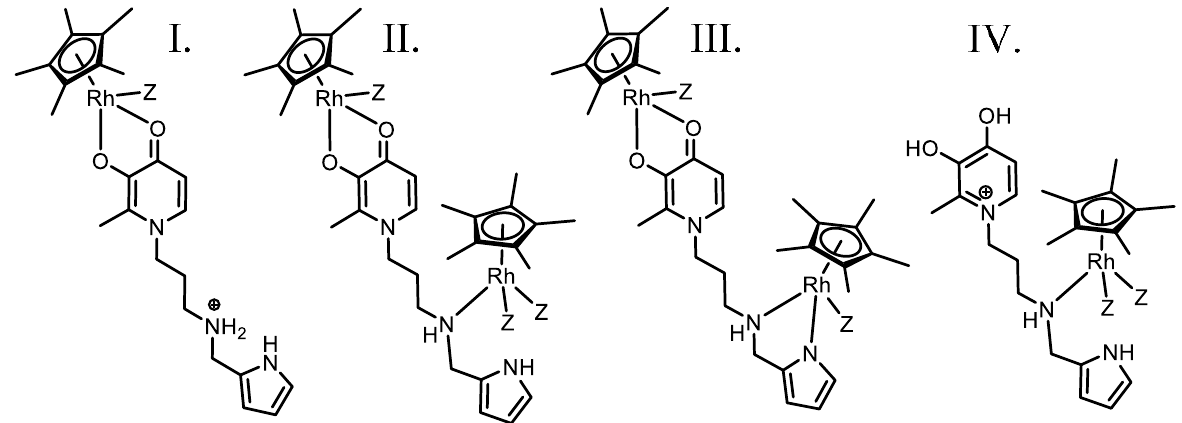
Figure 8. Suggested structures of the species in the [( η 5 -Cp*)Rh] 2+ –L3 system (Z = Cl − /H 2 O), charges of the metal ions are omitted for clarity. ( I ) [MHL] 2+ (•); ( II ) [M 2 L] 3+ (~); ( III ) [M 2 H –1 L] 2+ (η); ( IV ) [MH 2 L] 3+ (o); symbols represent the notation of the species in the NMR figures.